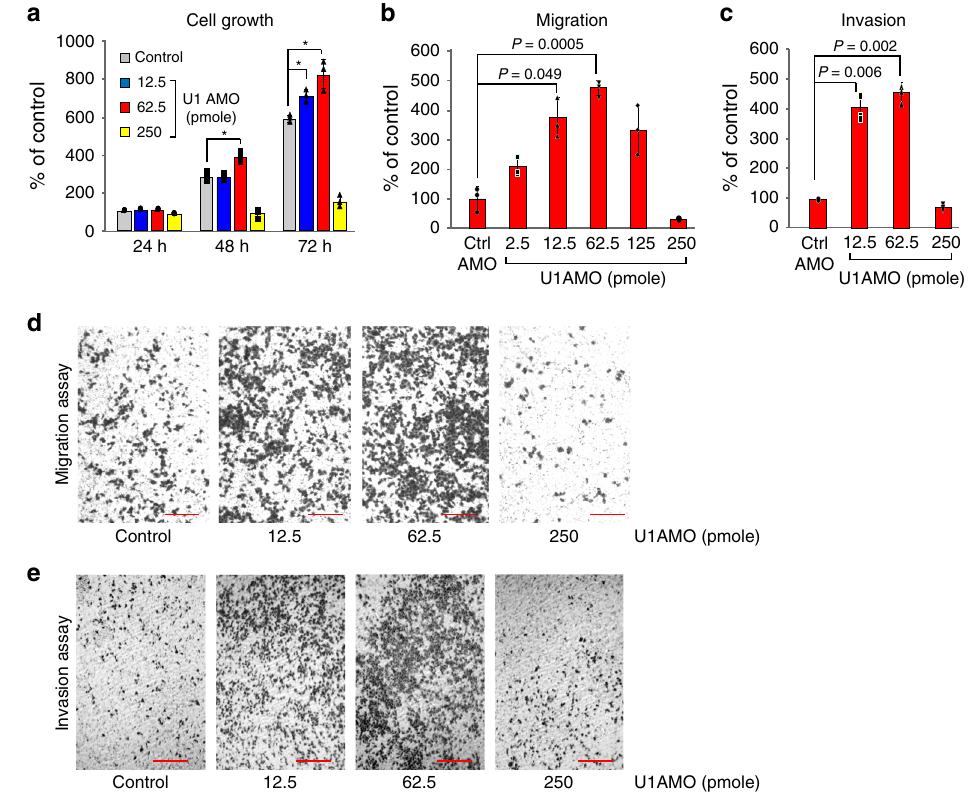
Fig. 1 Low U1 AMO dose-dependently enhances migration and invasion of HeLa cells in vitro. a HeLa cells were transfected with the indicated amounts of U1 or control AMOs. Cell proliferation was determined from cell numbers using the Cell Titer-Glo Luminescent Cell Viability Assay at the times indicated. Data are represented as mean ± standard deviation (SD) ( n = 3, independent cell culture). P -value was calculated with two-tailed Student ’ s t -test. The asterisk indicates P < 0.05. b , c Migrating and invading cells were measured 24 h post-transfection. 1.5 × 10 5 and 2.5 × 10 5 cells were cultured